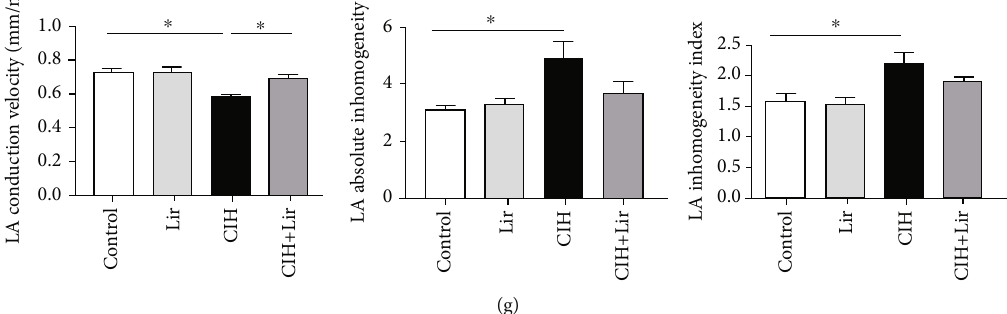
Figure 3: Lir reduces atrial fi brillation (AF) inducibility and AF duration induced by burst pacing and improves epicardial electrophysiological parameters. (a) Representative atrial electrogram recordings. Burst pacing is highlighted by solid underlines, whereas dashed underlines indicate AF. (b) Percentage of successful AF inducibility in each group ( n = 6 ). (c) Average AF duration by burst pacing ( n = 6 ). (d) Representative maps of spontaneous right atrial epicardial activation. (e) The comparison of right atrial (RA) epicardial conduction velocity, absolute inhomogeneity, and inhomogeneity index is detailed ( n = 6 ). (f) Representative maps of spontaneous left atrial epicardial activation. (g) The comparison of left atrial (LA) epicardial conduction velocity, absolute inhomogeneity, and inhomogeneity index is detailed ( n = 6 ). Data are mean ± SEM , ∗ P < 0 : 05